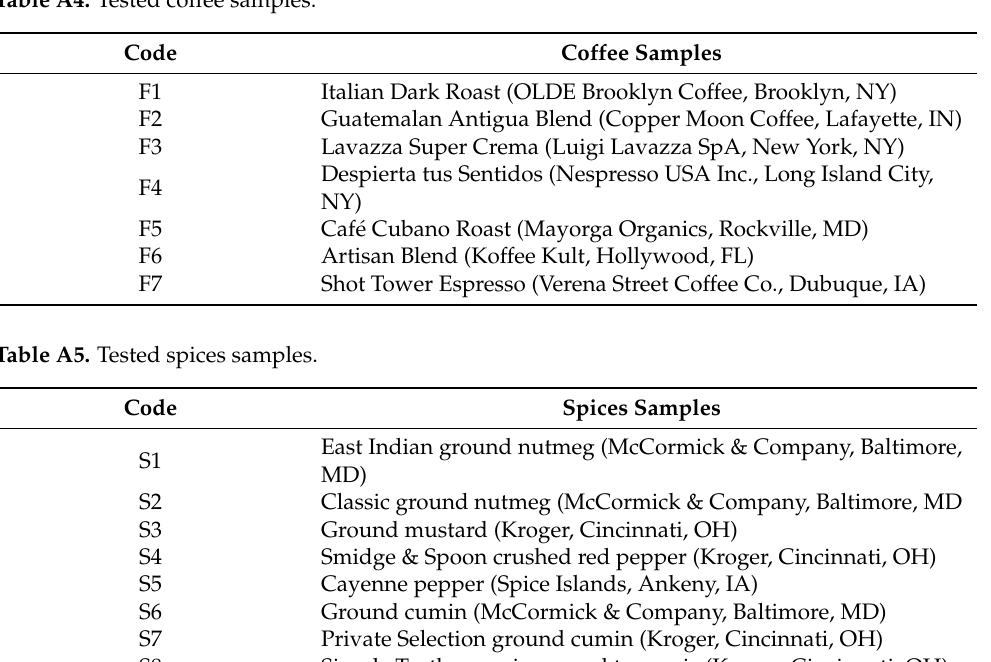
Table A4. Tested coffee samples.